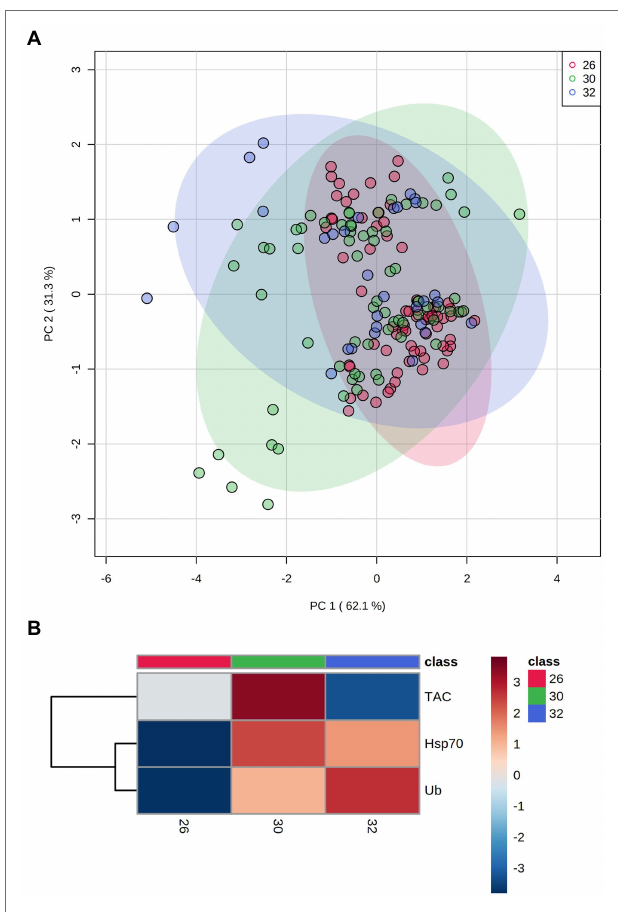
FIGURE 4 | Differences in biomarker profiles of corals exposed to three temperature conditions: 26 vs. 30 vs. 32 ° C. (A) PCA score plot of biomarker profiles; (B) heatmap of clustered biomarkers; in the color scale, red indicates higher than mean concentration, and blue indicates lower than mean concentration. Rows are biomarker concentrations and columns are group averages. Significant differences were found for biomarker profiles between temperature conditions ( Table 2